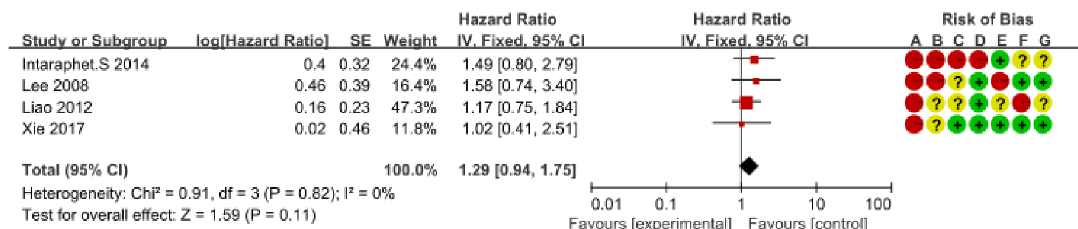
Fig 4. Forest plot of tumor homology and overall survival of small cell carcinoma of the cervix patients. SE: standard error; CI: confidence